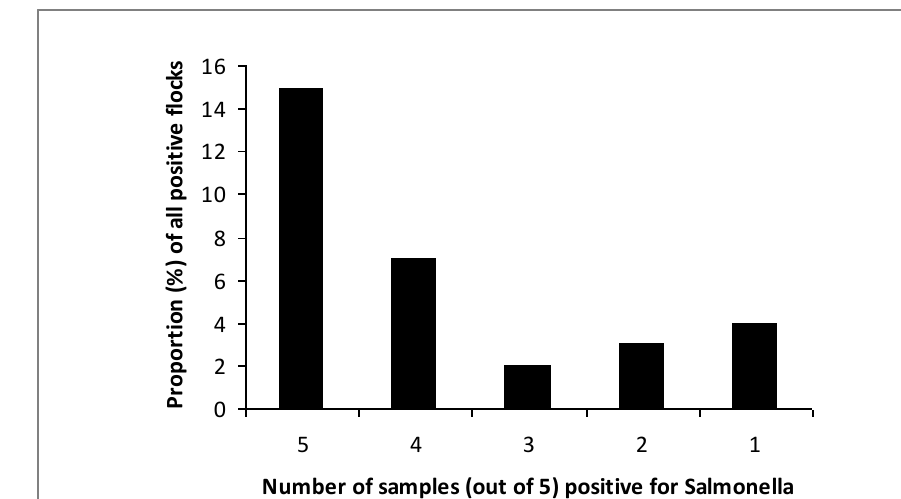
Figure 1. Number of samples positive for Salmonella in flocks with at least one finding (out of five pooled samples